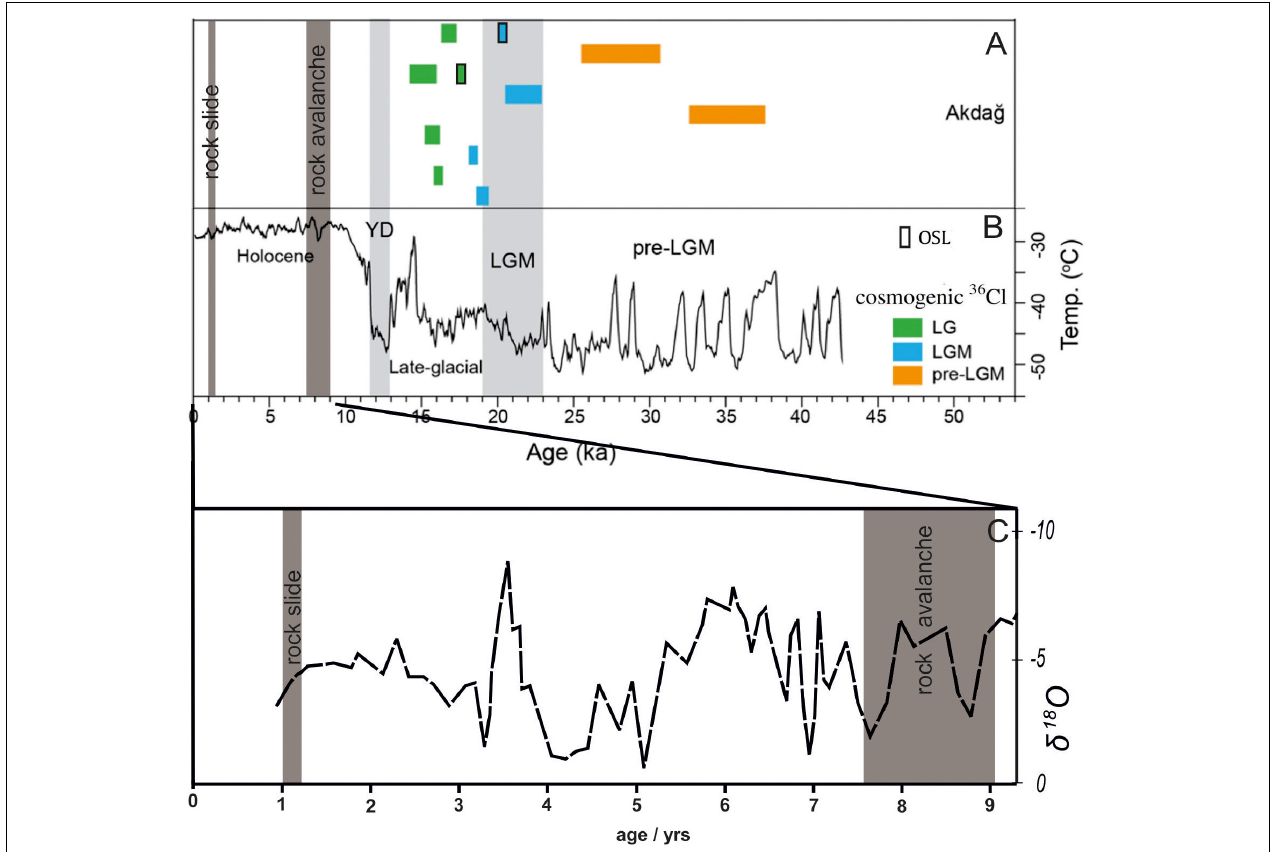
FIGURE 14 | Comparison between OSL dating (Bayrakdar, 2012; Bayrakdar et al., 2017) and cosmogenic surface exposure dating (Sarıkaya et al., 2014) for the Akdag Massif glacial chronology (Sarıkaya and Çiner, 2015). (A) Past surface temperatures gathered by drilling cores from Greenland GISP 2 (Alley, 2000). (B) Correlation between δδ 18O climate data belonging to Gölhisar, located 70 km north of Akdag (Eastwood et al., 2007). (C) 36Cl exposure age of the rock avalanche and rockslide.